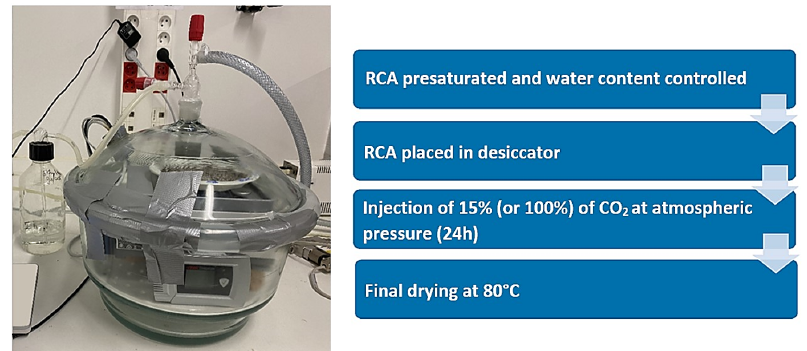
Figure 1. Experimental setup for the accelerated carbonation